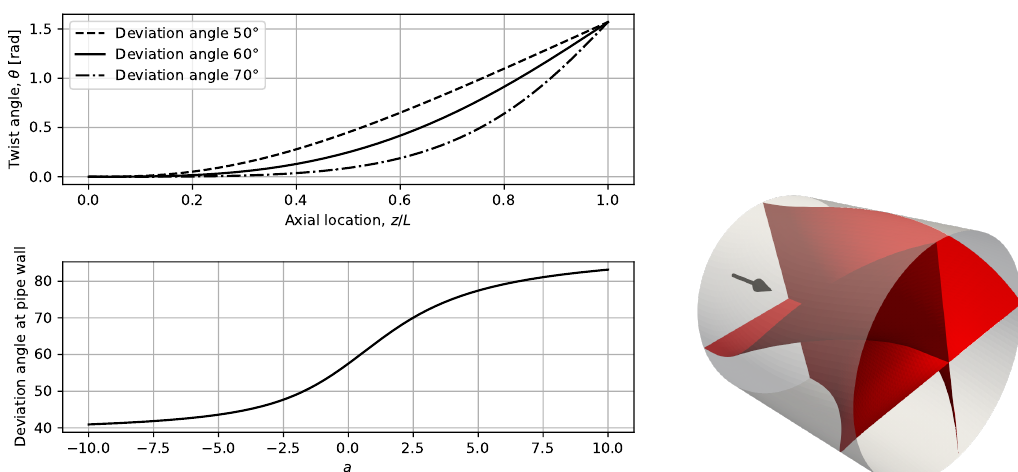
Figure 7. Case II, with four blades and twist angle dependent on radius. ( upper left ) twist angle as a function of axial location for various deviation angles; ( lower left ) deviation angle as a function of parameter a; ( right ) the blade set up in the pipe. Note that the arrow shows the direction of the flow in front of the inlet.